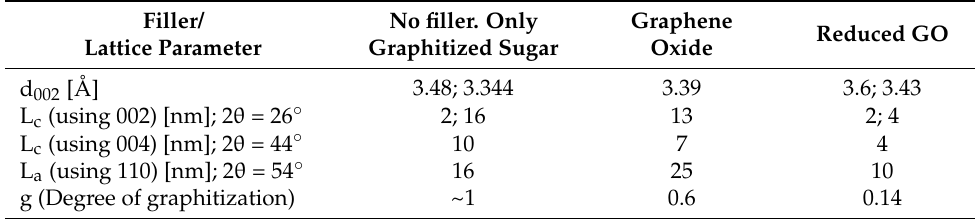
Table 1. Summary of the crystallite parameters of the listed composites after high-temperature heat